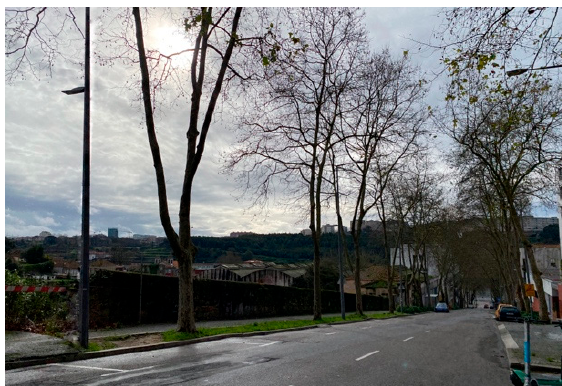
Figure 22. Porto. Site.